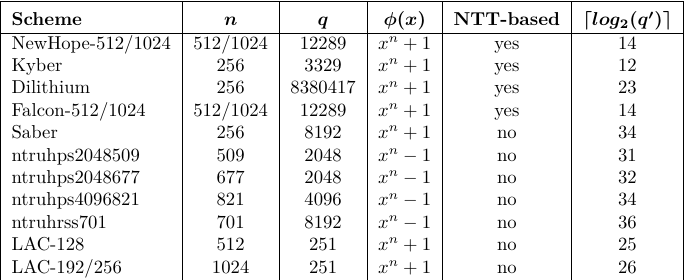
Table 1: NTT parameters of several lattice-based